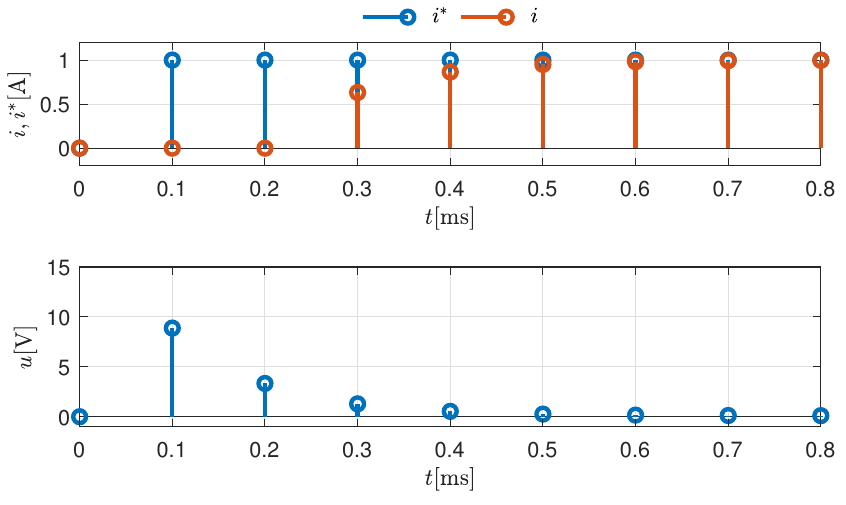
Figure 6. Current response and control signal for a step change in the reference current for a system with τ H = T s (for discrete system, T s = 0.1